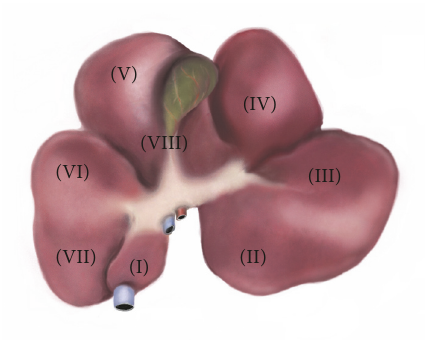
Figure 1: Segmental anatomy of the porcine liver. Caudate lobe: segment (I). Left lateral lobe: segments (II) and (III). Left medial lobe: segment (IV). Right medial lobe: segments (V) and (VIII). Right lateral lobe: segments (VI) and